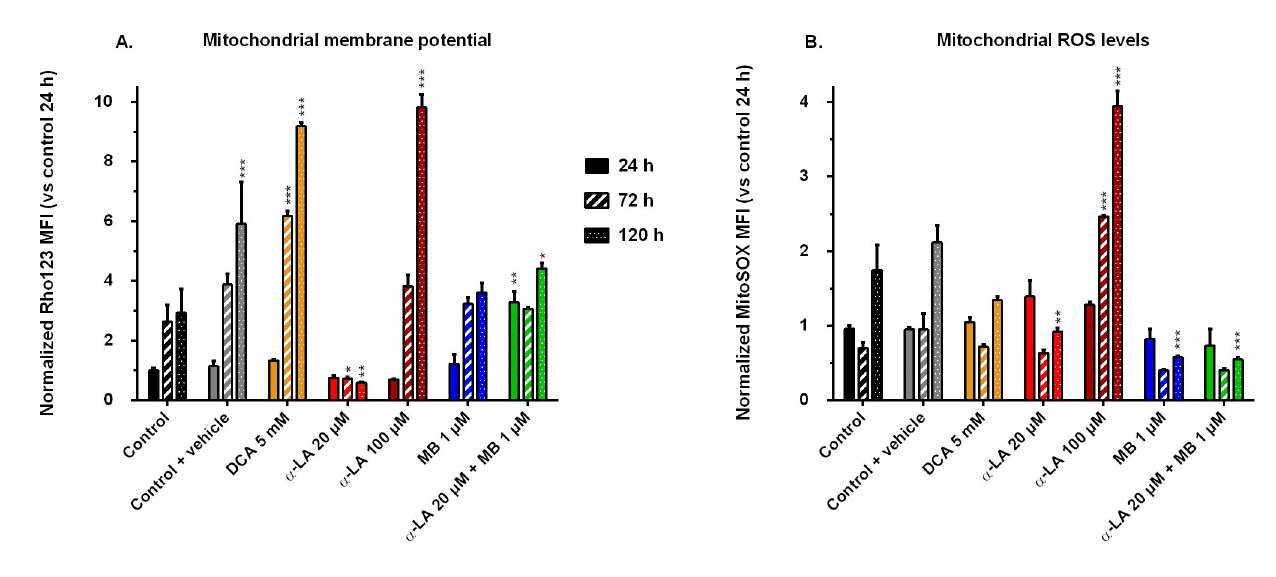
Fig 4. Mitochondrial membrane potential and reactive oxygen species (ROS) levels induced by the drugs. Mean fluorescence intensity (MFI) was measured by FACS after staining with Rhodamine123 (A) for the mitochondrial membrane potential, and with MitoSOX (B) for the levels of superoxide ions located at the mitochondria. All values are presented as means ± SEM with arbitrary units (normalized versus the MFI of the control at 24 h).